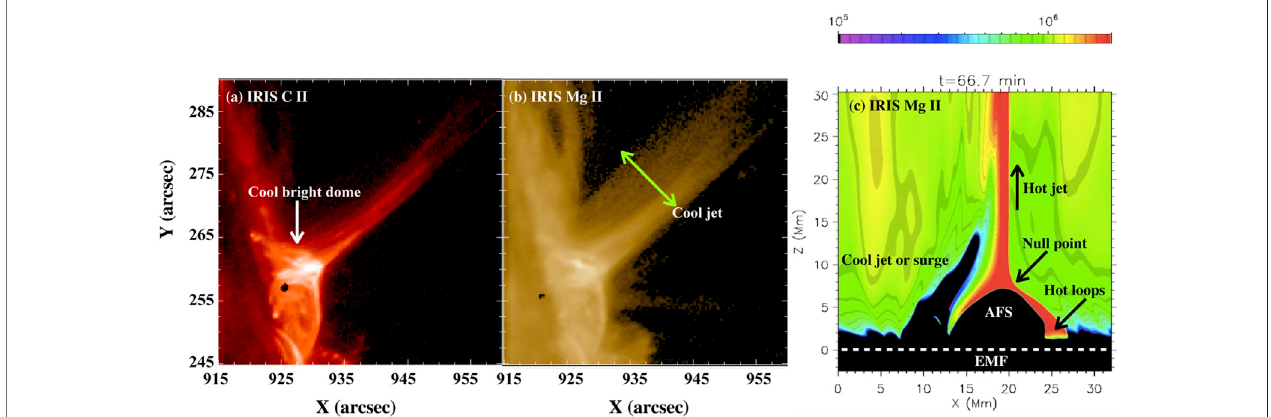
FIGURE6| IRISjetobservedinCIIonApril4,2017,showingabrightdomesignatureofemerging fl uxwithanullpoint (A) ,inMgIIshowingthelargecoolsurge (B) (from Joshi et al. (2020a)), and (C) snapshot of the 3D MHD simulation of Nóbrega-Siverio et al. (2016).